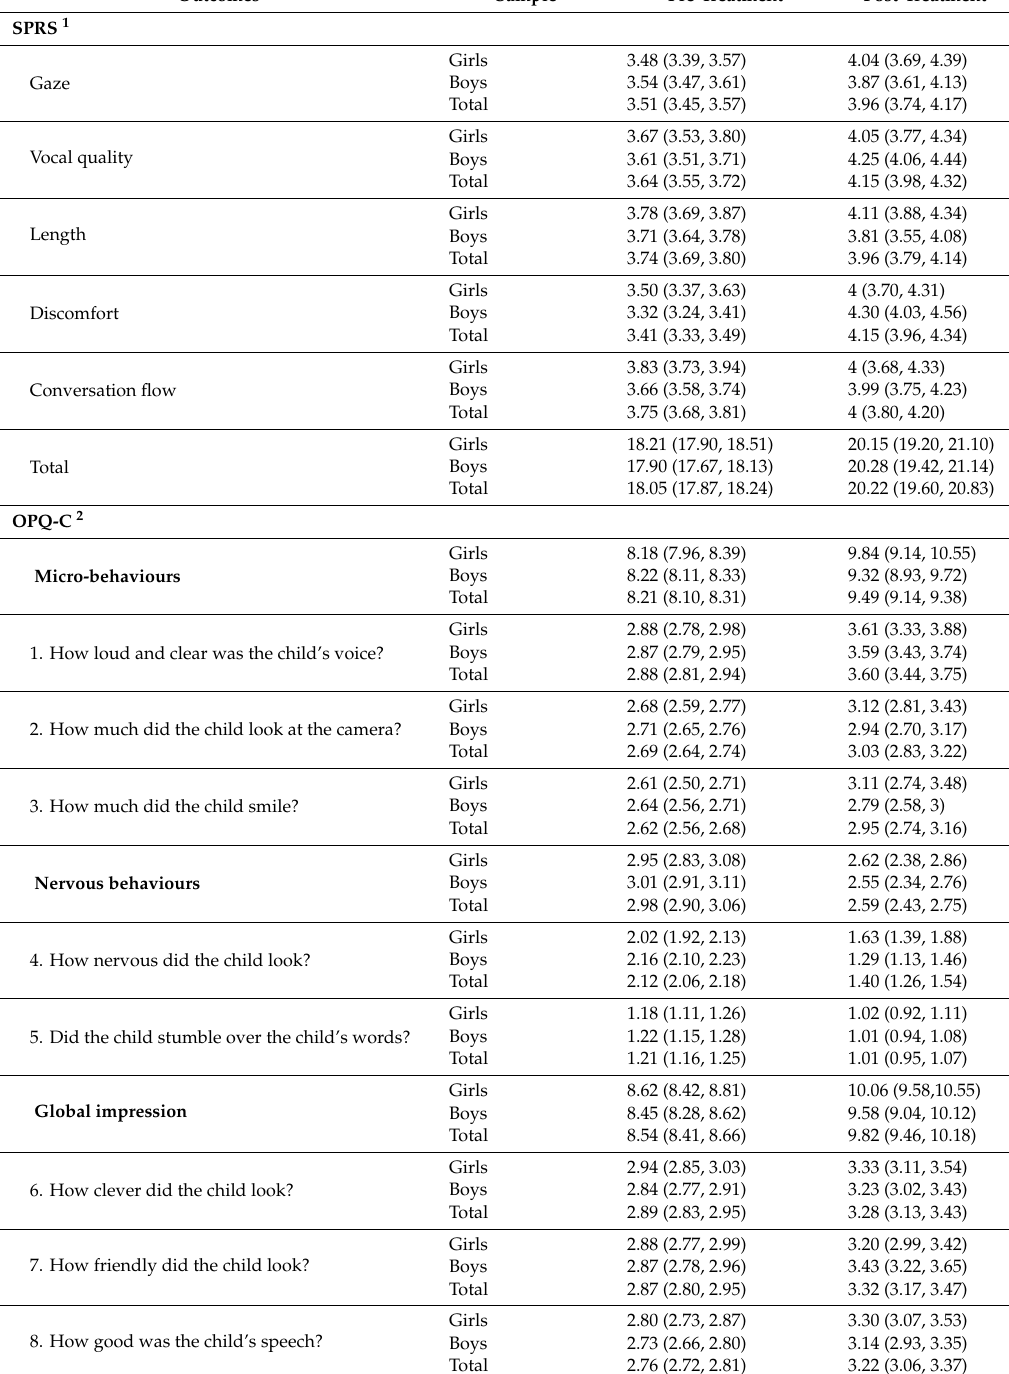
Table 2. Estimated marginal means (95% confident interval) of the outcomes pre-test and post-test by